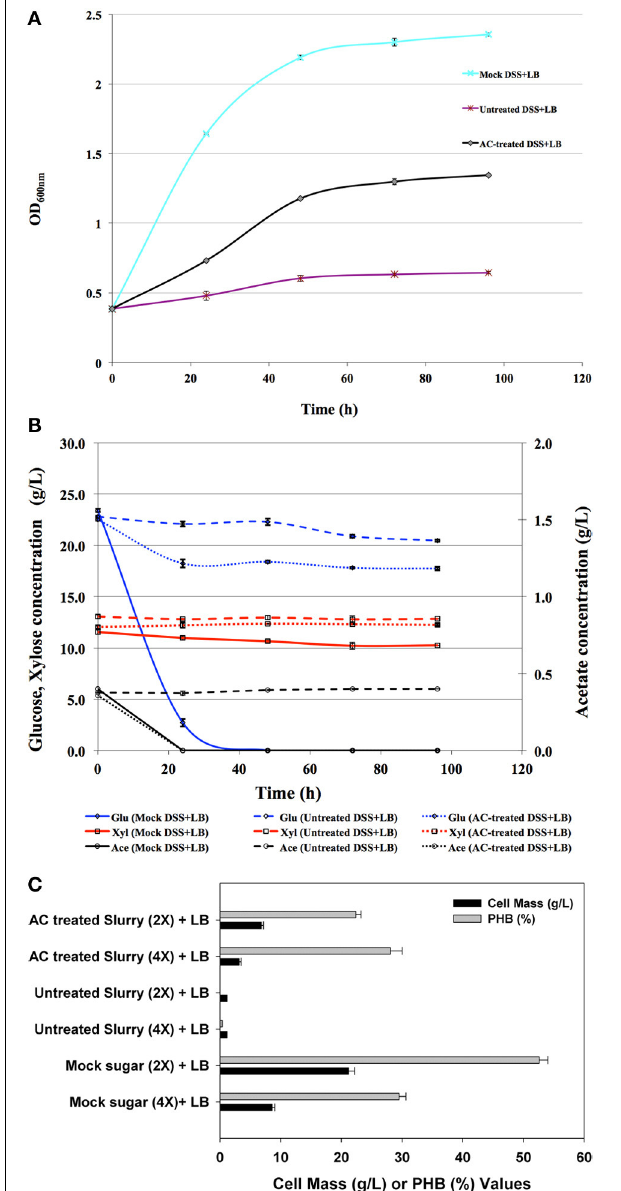
FIGURE 2 | Growth of C. necator on 4-fold (4 × ) diluted untreated and activated carbon (AC) treated saccharified slurry as well as the mock medium (A), and the corresponding sugar (Glu, glucose; Xyl, xylose) and acetate (Ace, acetate) concentrations (B), as well as cell mass and PHB yield with 2-fold or 4-fold dilution 96-h post-inoculation (C).